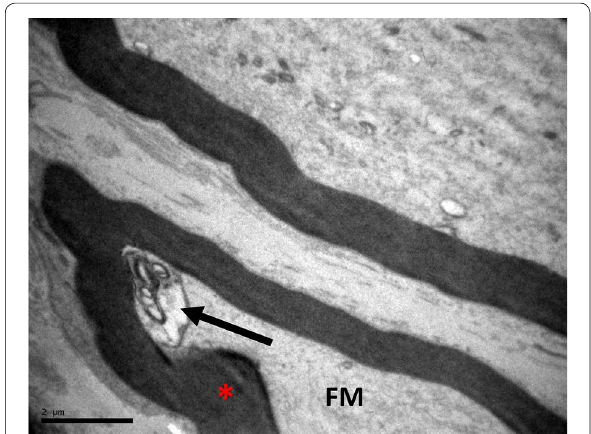
Fig. 1 Control group: Femoral nerve (FM) with no major changes with the exception of some spots of thickness of the nerve myelin sheath (red asterisk) and small detachment of the axon (arrow)